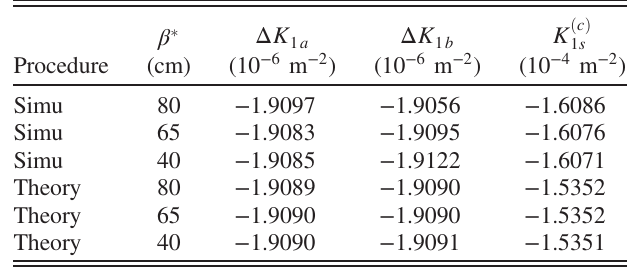
TABLE VIII. Corrector strengths for LHC lattices with differ- ent nominal values of β (cid:1) . The values with label “ simu ” are obtained as in Sec. VII, while the values with label “ theory ” are directly obtained from Eqs. (20) and